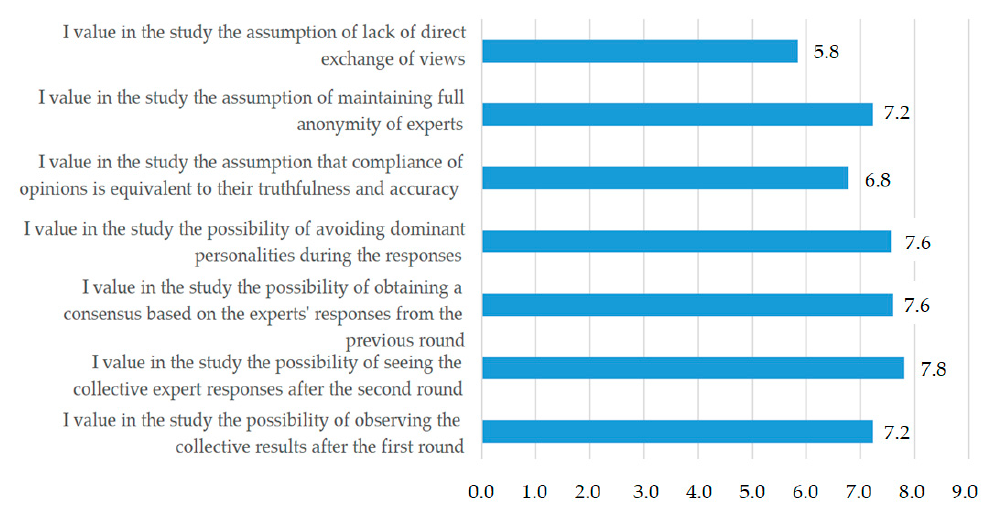
Figure 5. Experts’ belief in the binding rules of the Delphi method study (mean values, sample n = 30); own elaboration based on the conducted research.